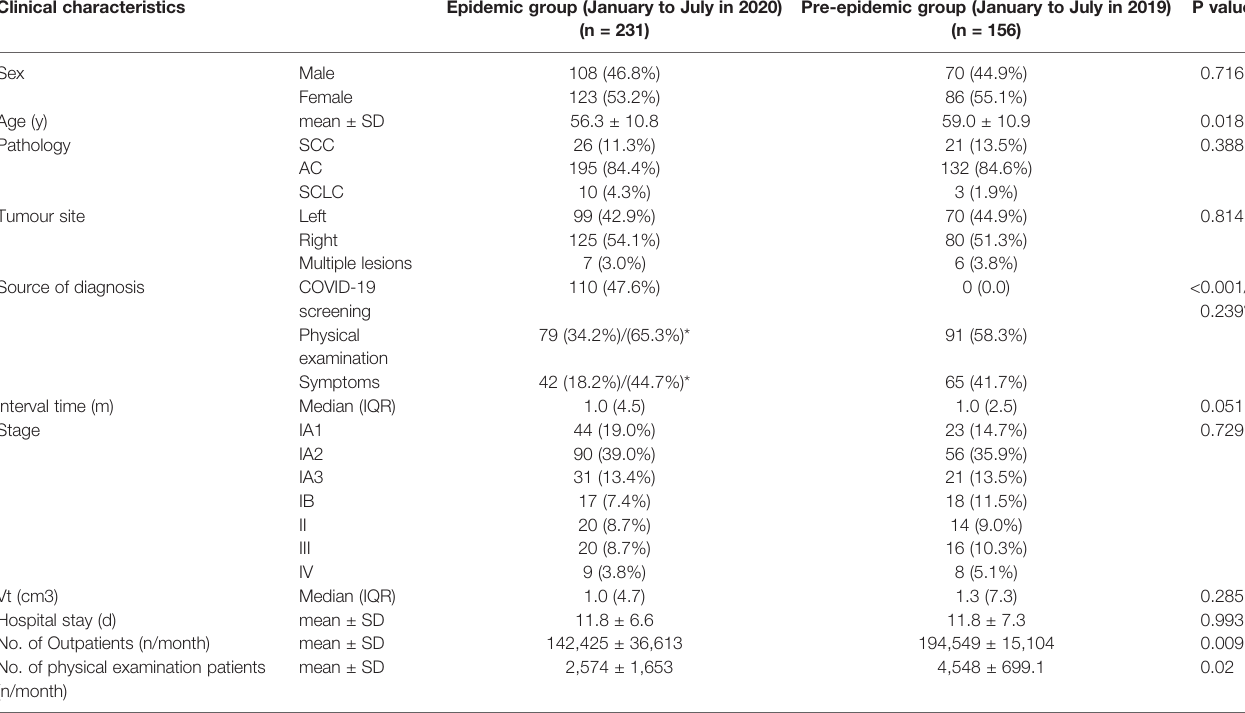
TABLE 1 | The clinical characteristics of newly diagnosed lung cancer patients between the epidemic groups and the pre-epidemic groups. Clinical